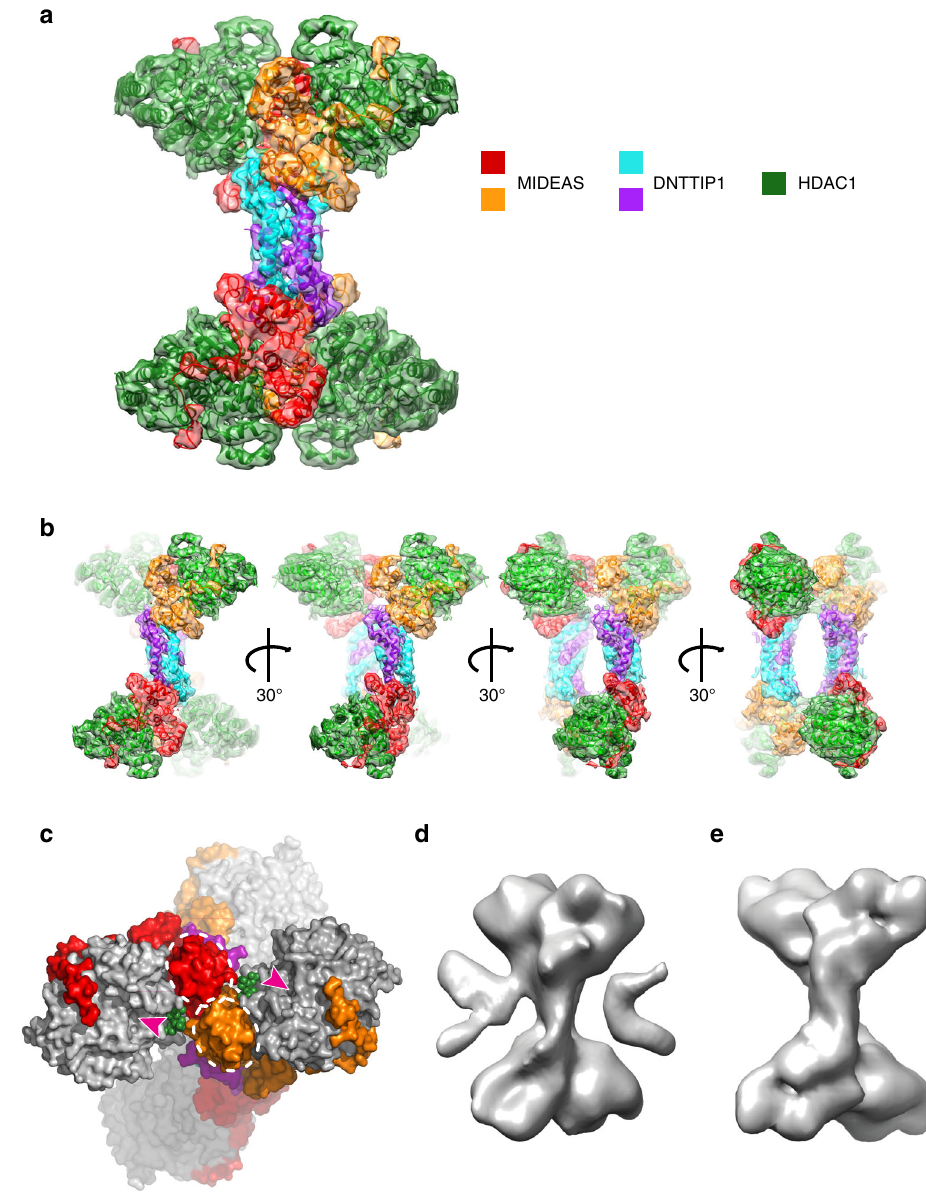
Fig. 6 The structure of the tetrameric MiDAC complex. a Post-processed cryo-EM map of the tetrameric complex from Relion3 with the protein chains shown as cartoons. The map is coloured according to the protein. Map contour level is 0.015 — Chimera. b 30° rotations of the MiDAC tetramer with enhanced depth-cue. c End-on view of the MiDAC illustrating the interactions between the MIDEAS-SANT domains and InsP6 at the tetramerisation interface. The InsP6 is shown in green, the HDACs in grey surface and the positions of the HDAC1 active sites are indicated with magenta arrowheads. The MIDEAS-SANT domains are indicated by white dotted ovals. d Cryo-EM map of the complex with the DNA-binding domain from DNTTIP using C1 symmetry and no mask. e Cryo-EM map of the complex with the DNA-binding domain from DNTTIP using D2 symmetry and a